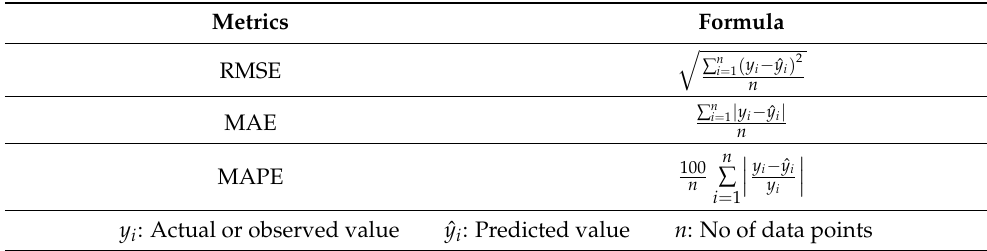
Table 4. Performance